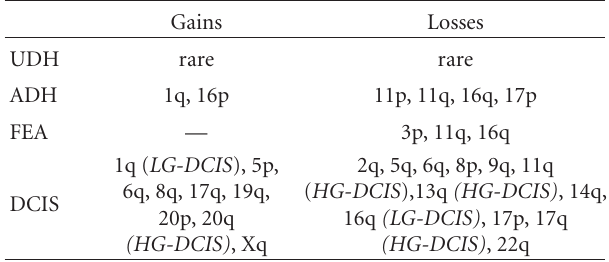
Table 2: “hot spots” in IPLs—more frequent allelic imbalances